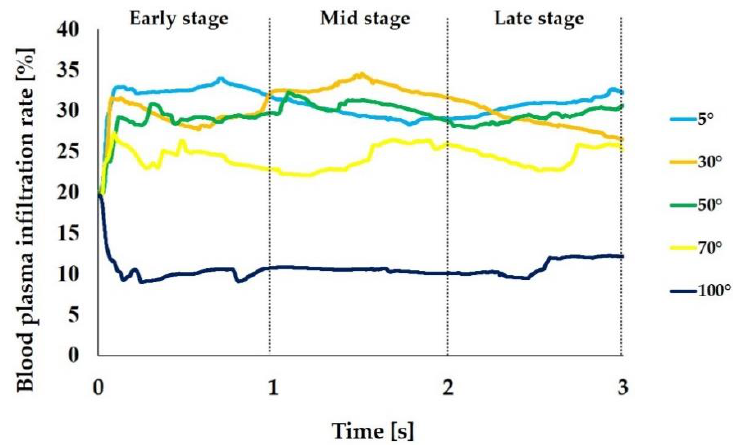
Figure 7. Blood plasma infiltration rate (%) varying with different levels of hydrophilicity or hydrophobicity of the implant surfaces. The mass of blood plasma located in the interfacial zone relative to the one in the entire surrounding area is expressed in %.